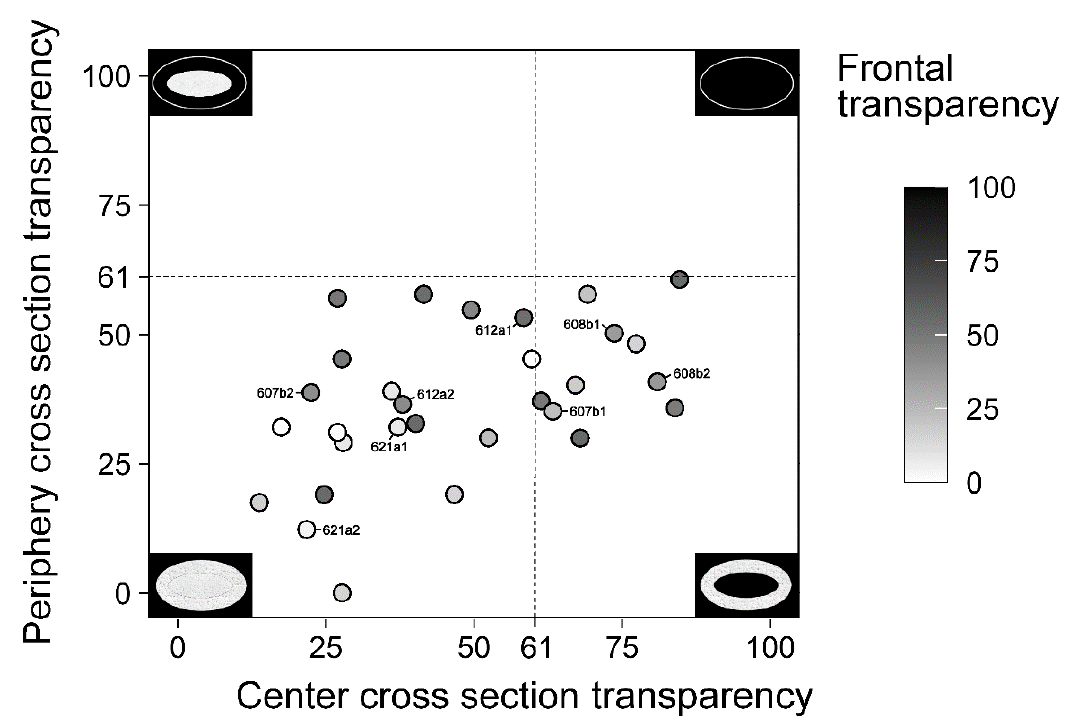
Figure 4. Scatter plot comparing the transparency of sample cross sections at the periphery and center. The inner color of each circle expresses the frontal transparency. The closer a value is to 0, the opaquer it is and the closer a value is to 100 the more transparent it is. 4 schematic drawings representing maximum transparency/opacity at the periphery or center can be seen at the 4 edges of the plot. For examples, the bottom left represents a sample that has a transparency of 0 both at the periphery and center. The bottom right represents a sample that has a transparency of 0 at the periphery and 100 in the center. The dashed line at 61 is the cut-off value for what we defined as transparent. Table 3. Comparison of different morphological results among our samples when separating them in to two groups based on the central transparency of their cross-sections. The mean results of transparency (ranging from 0 = most opaque sample to 100 = Transparent) and cross section area size were compared. Statistical significance of mean results was calculated with t -Test.